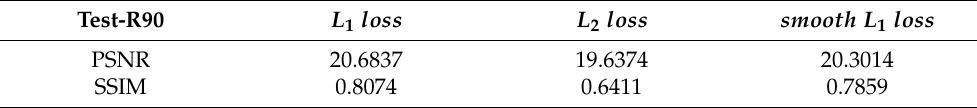
Table 11. Results of different loss functions under the Mixed dataset.